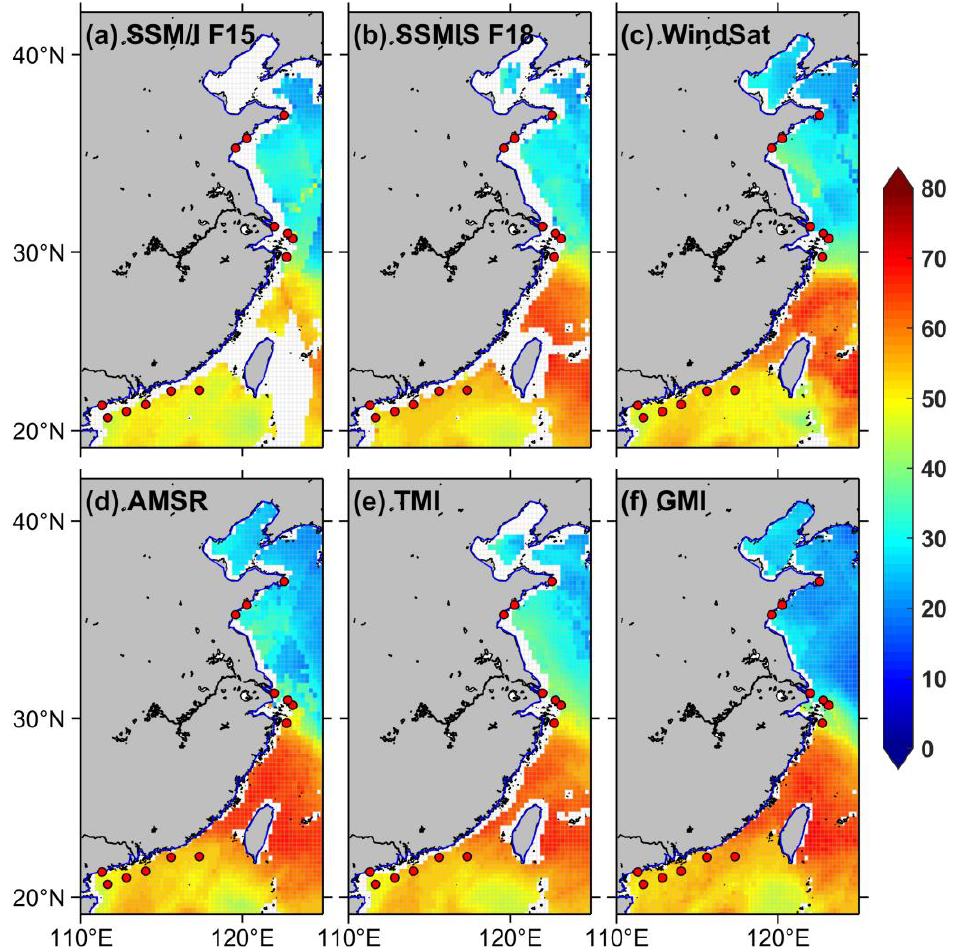
Figure 2. Comparison of 3-day running averaged TPW data on 1 June 2014, from various types of sensors. ( a – f ) Sensors SSM/I F15, SSMIS F18, WindSat, AMSR, TMI, and GMI, respectively. Red dots are stations located in coastal areas. Note that different sensors have different scopes of data coverage in coastal areas.